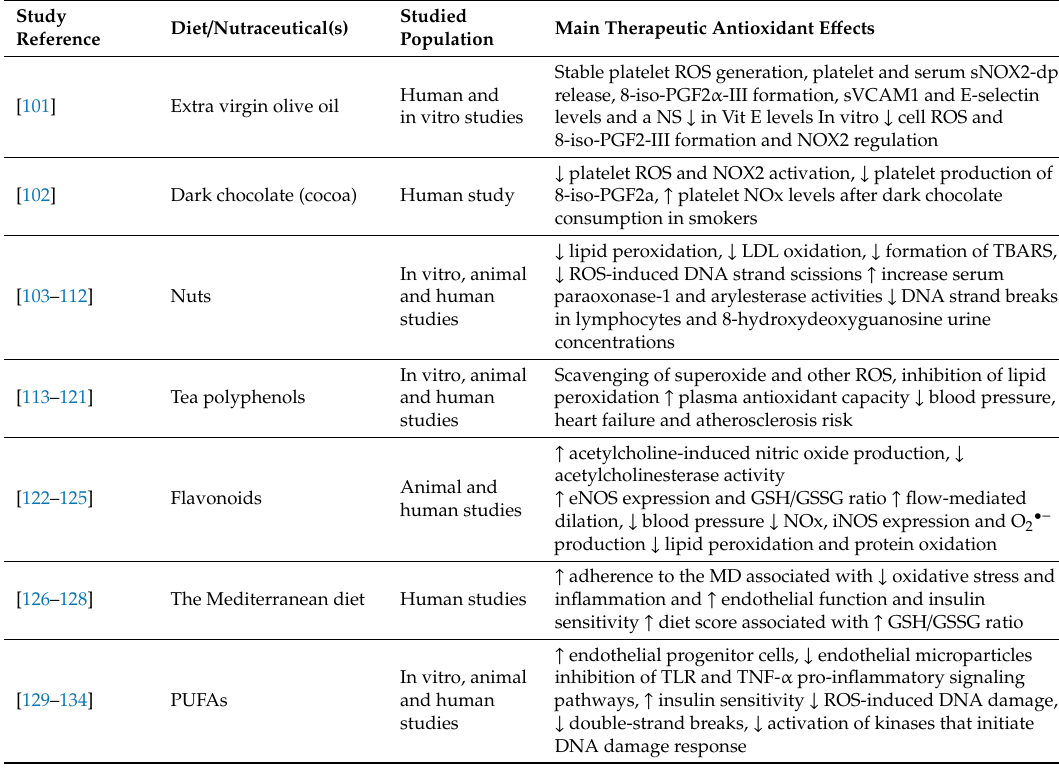
Table 1. Diets and nutraceuticals investigated regarding their potential therapeutic antioxidant e ff ects. Study